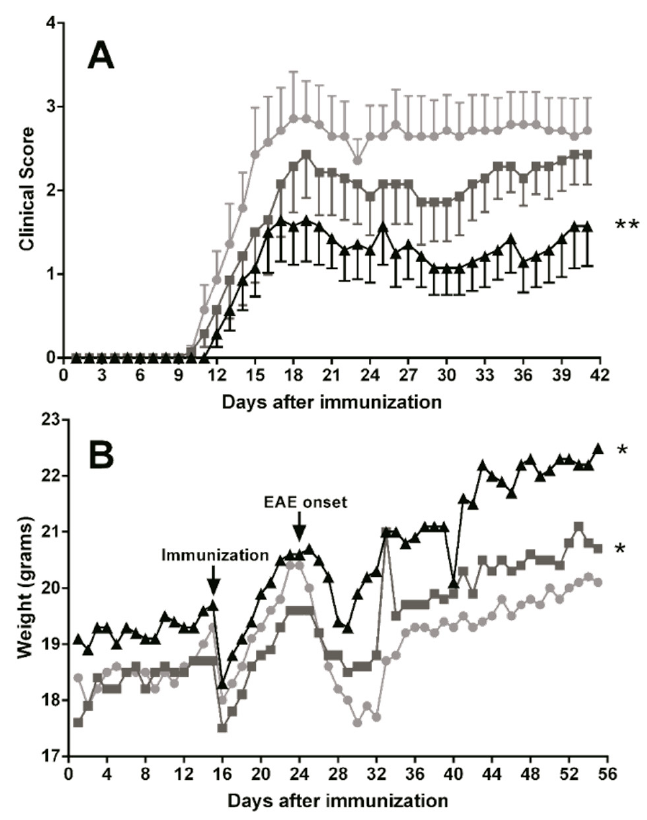
Figure 6. Dietary DHA improved the outcome of experimental autoimmune encephalomyelitis. EAE-induced C57BL/6 mice were fed with a normal diet in an untreated group ( n = 10, ● ) or a normal diet supplemented with TG-DHA 50 ( n = 10, ■ ) or 250 mg/kg/day ( n = 10, ▲ ) for 56 days. Mice were immunized with MOG35–55 as described in the Methods section. Kinetics of mean clinical score ( A ) and percentage change in weight ( B ) were controlled daily and compared day-by-day with the untreated group. Survival at the end of the observation period was also assessed. * = p < 0.05, ** = p < 0.01.